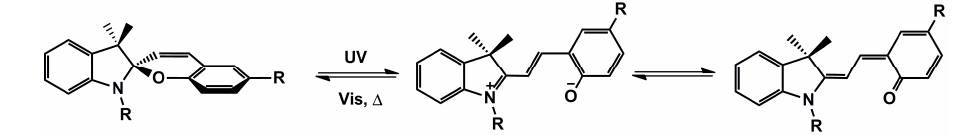
Figure 12. Spiropyran–merocyanine transformation with mesomeric structure.